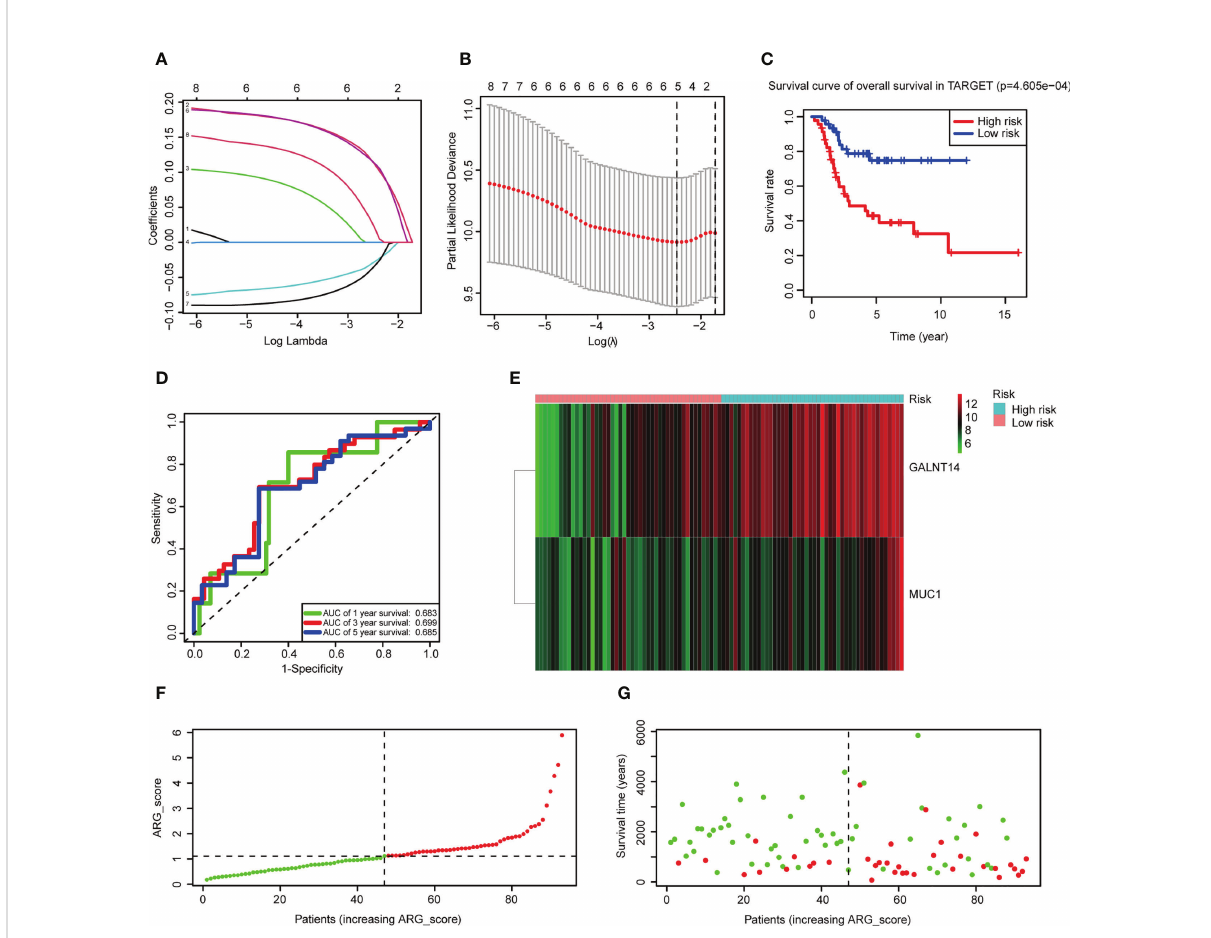
FIGURE 4 Construction of the risk score model. (A) LASSO regression was used to screen the prognostic genes. (B) Cross-validation indicated that fi ve genes can be used in multivariate Cox regression. (C) K-M plots comparing overall survival between the low- and high-risk groups in the Therapeutically Applicable Research to Generate Effective Treatments (TARGET) dataset (log-rank p -value = 4.605e − 4). (D) Time-dependent ROC curves to predict the discrimination of the 1-, 3-, and 5-year survival according to the risk score model in the TARGET dataset. (E) A heatmap of two prognostic hub genes of the TARGET dataset in the two subgroups. Red means high expression and green means low expression. (F, G) Ranked dot and scatter plots of the TARGET dataset showing the ARG_score distribution and patient survival